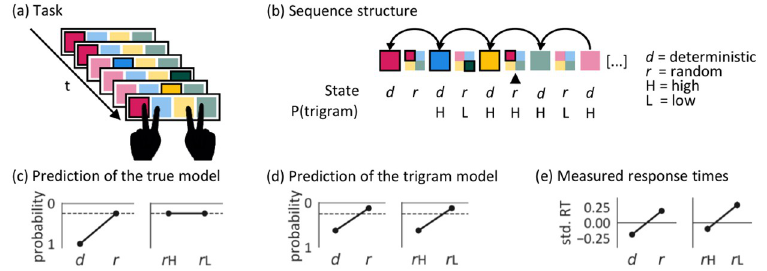
Fig 1. The Alternating Serial Reaction Time (ASRT) task with second-order dependence structure. (a) Participants had to press the key corresponding to the current sequence element (i.e. cue location) on the screen as accurately and quickly as possible, using the index and middle fingers of both hands. In the display, the possible locations were outlined in black and the cue always looked the same, fill color and saturation are only used here for explanatory purposes. (b) The structure of the example sequence segment in (a). Color saturation and outline indicate the element that was presented on a trial. The vertical arrow indicates the current trial. The task was generated from an eight element second-order sequence where every second element was deterministic and the elements in between were random. The deterministic components in this example are: red-blue-yellow-green. The element on any random trial (including the current one) is unpredictable. However, this current trial happens to mimic the deterministic second- order dependence where green is followed by red after a gap of one trial, making it a high probability trigram trial (H). The other random elements were associated with lower probability trigrams (L). (c) Under the true generative model, when in a random state, high-probability trigrams ( r H) and low-probability trigrams ( r L) are equally unexpected. (d)